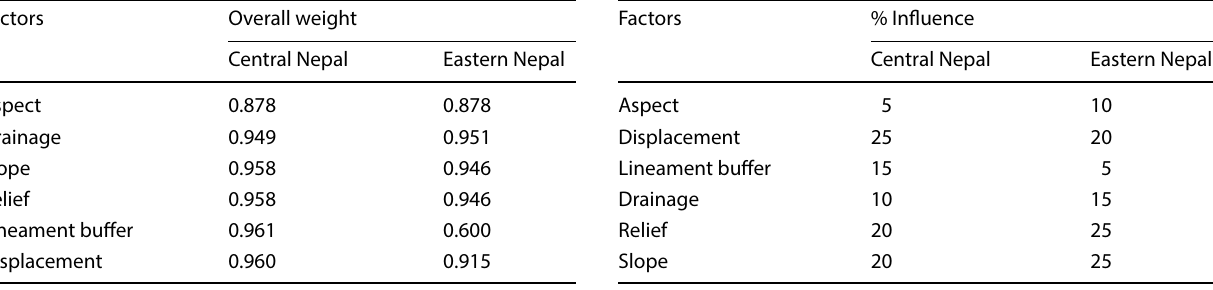
Table 5 Overall weight of each factor to obtain the percentage influence